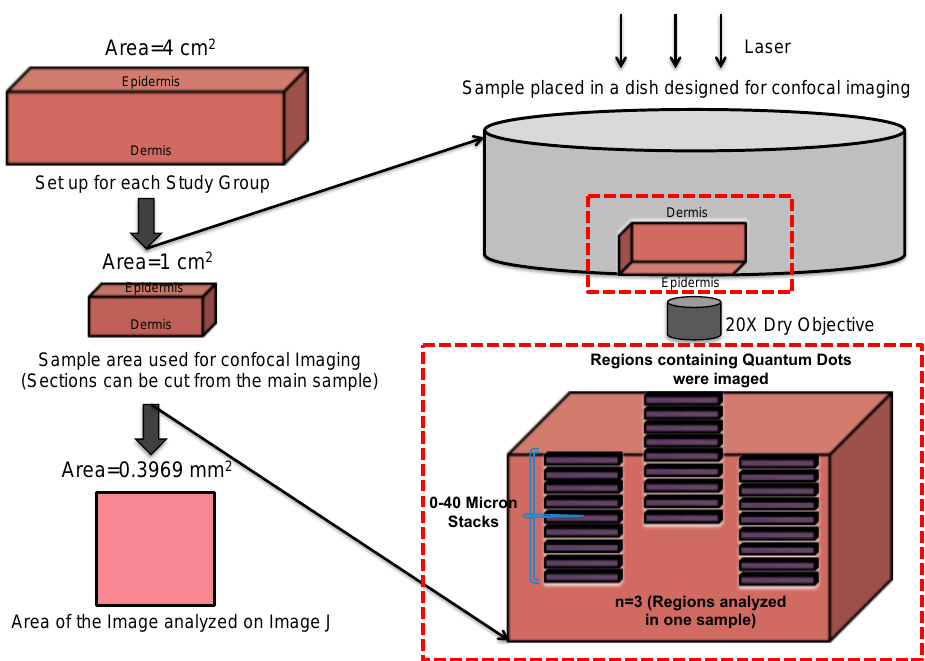
Figure 1. Schematic of Confocal Imaging set up to quantify QD penetration through ex vivo mouse and human skin. Skin samples from mouse and human skin (~4 cm 2 area) were placed in a petri dish for the 24 h study. The vehicles were applied topically and the samples were placed in a humidifying chamber. The skin samples were wiped after the 24 h incubation and processed for Confocal